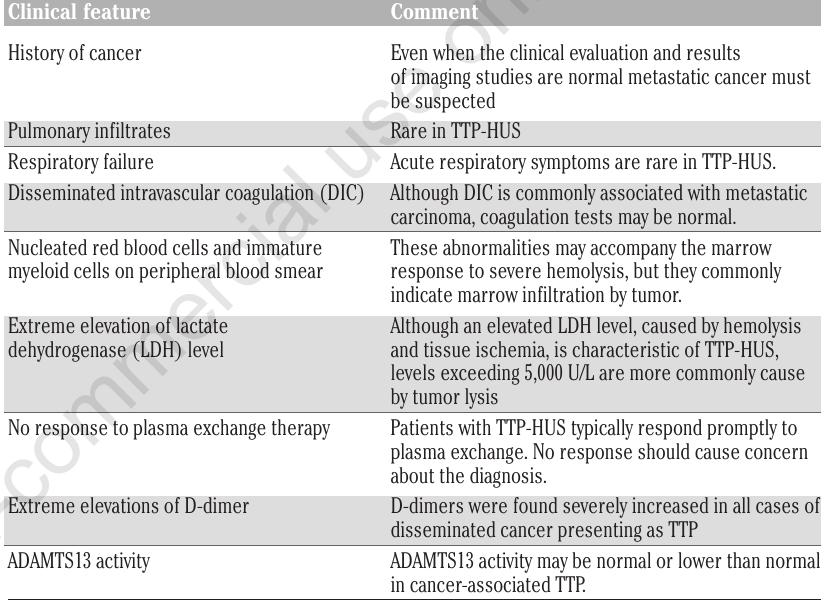
Table 1. Clinical features that may suggest disseminated malignancy as an alternative diagnosis in patients with assumed TTP-HUS. Clinical